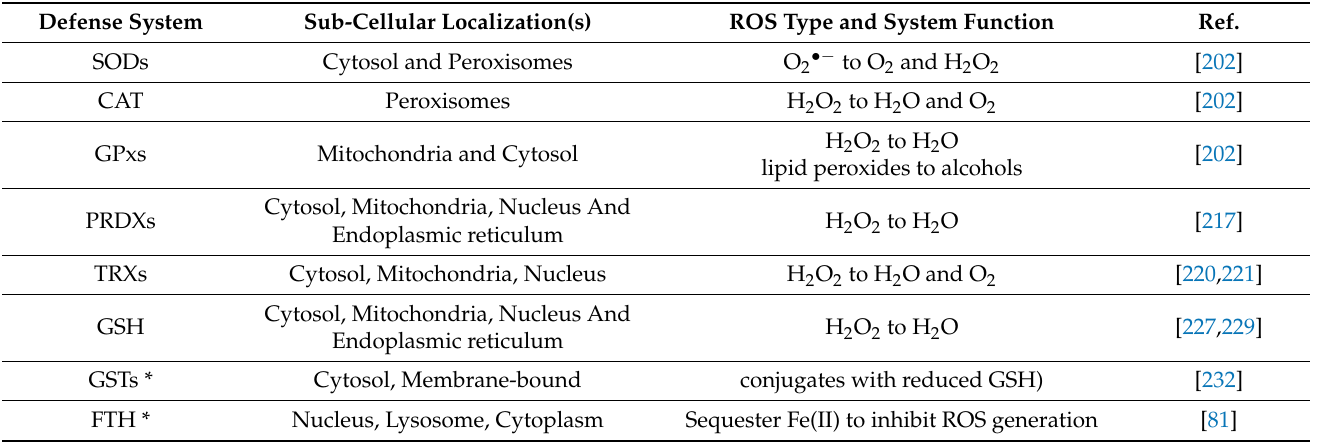
Table 1. The function of defense systems and their sub-cellular